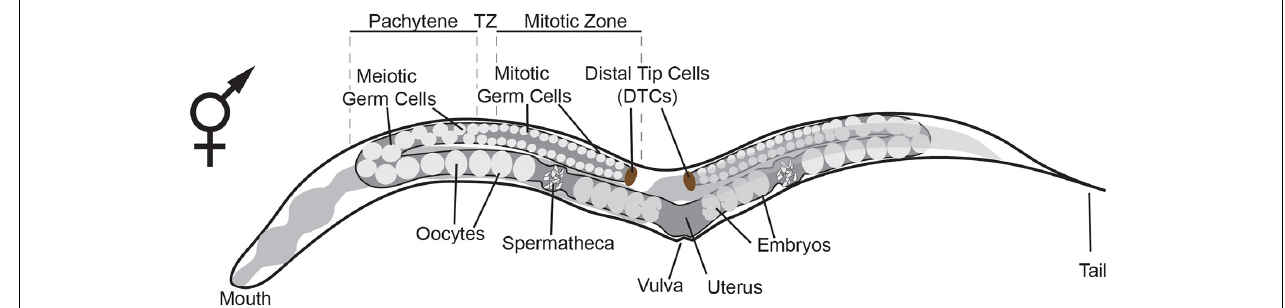
FIGURE 1 | Schematic representation of the adult hermaphrodite germline. The germline consists of two gonadal arms, with each arm containing mitotic germ cells, meiotic germ cells, oocytes and spermatheca. The somatic distal tip cells (DTCs) are located at the distal most end of the gonad where they control germline mitosis (Byrd et al., 2014). As germ cells move away from the DTC and reach the transition zone (TZ), they enter and proceed through meiosis. After the TZ, cells move through the pachytene where they grow until they enter the proximal arm as oocytes. Oocyte maturation is triggered by the spermatheca (Miller et al., 2001). The oocyte enters the spermatheca at ovulation and is fertilized giving rise to an